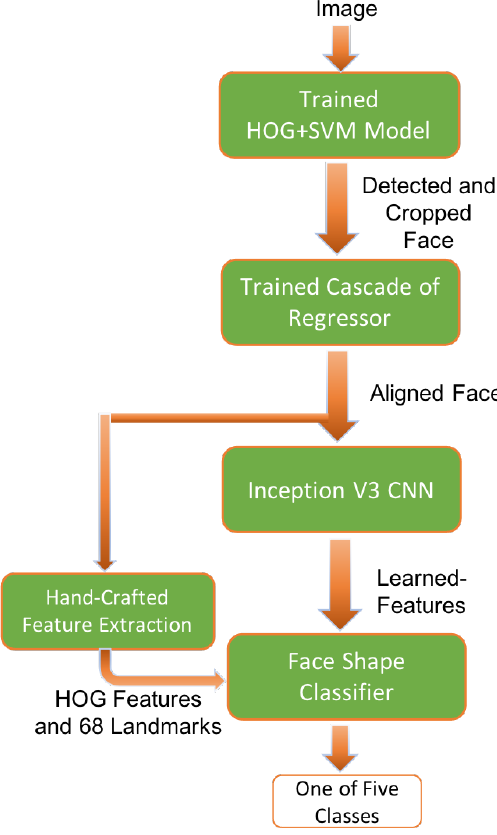
Figure 6. The developed face shape classification system